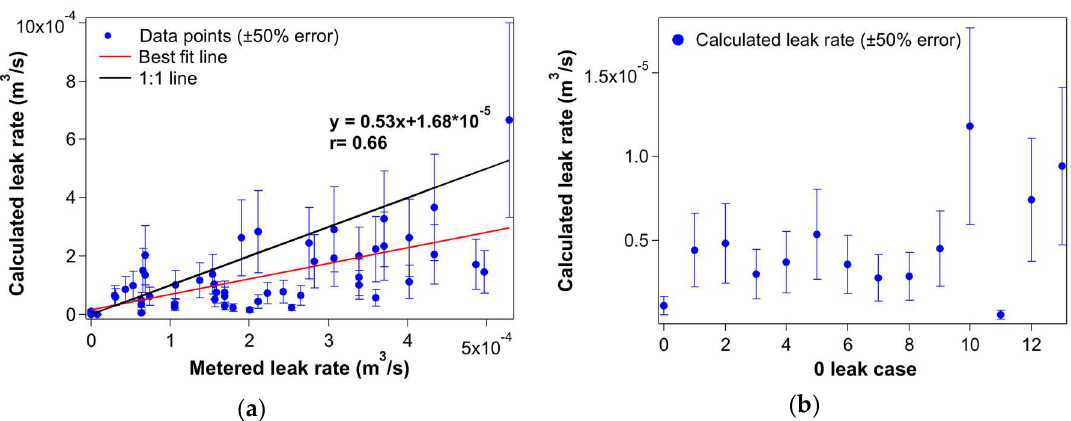
Figure 9. Calculated leak rate versus metered leak rate using the datasets collected from March–July 2017: ( a ) Comparison of calculated leak rate versus the metered leak rate. ( b ) Calculated leak rates of zero leak cases.